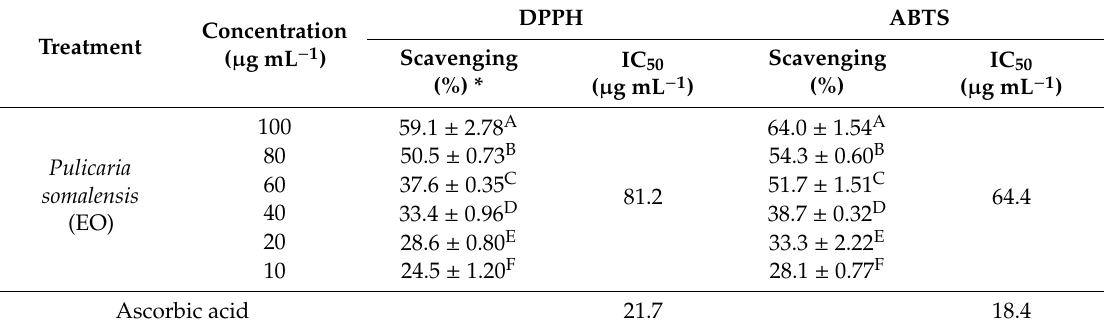
Percentage of scavenging activity of 2,2-Diphenyl-1-picrylhydrazyl (DPPH)